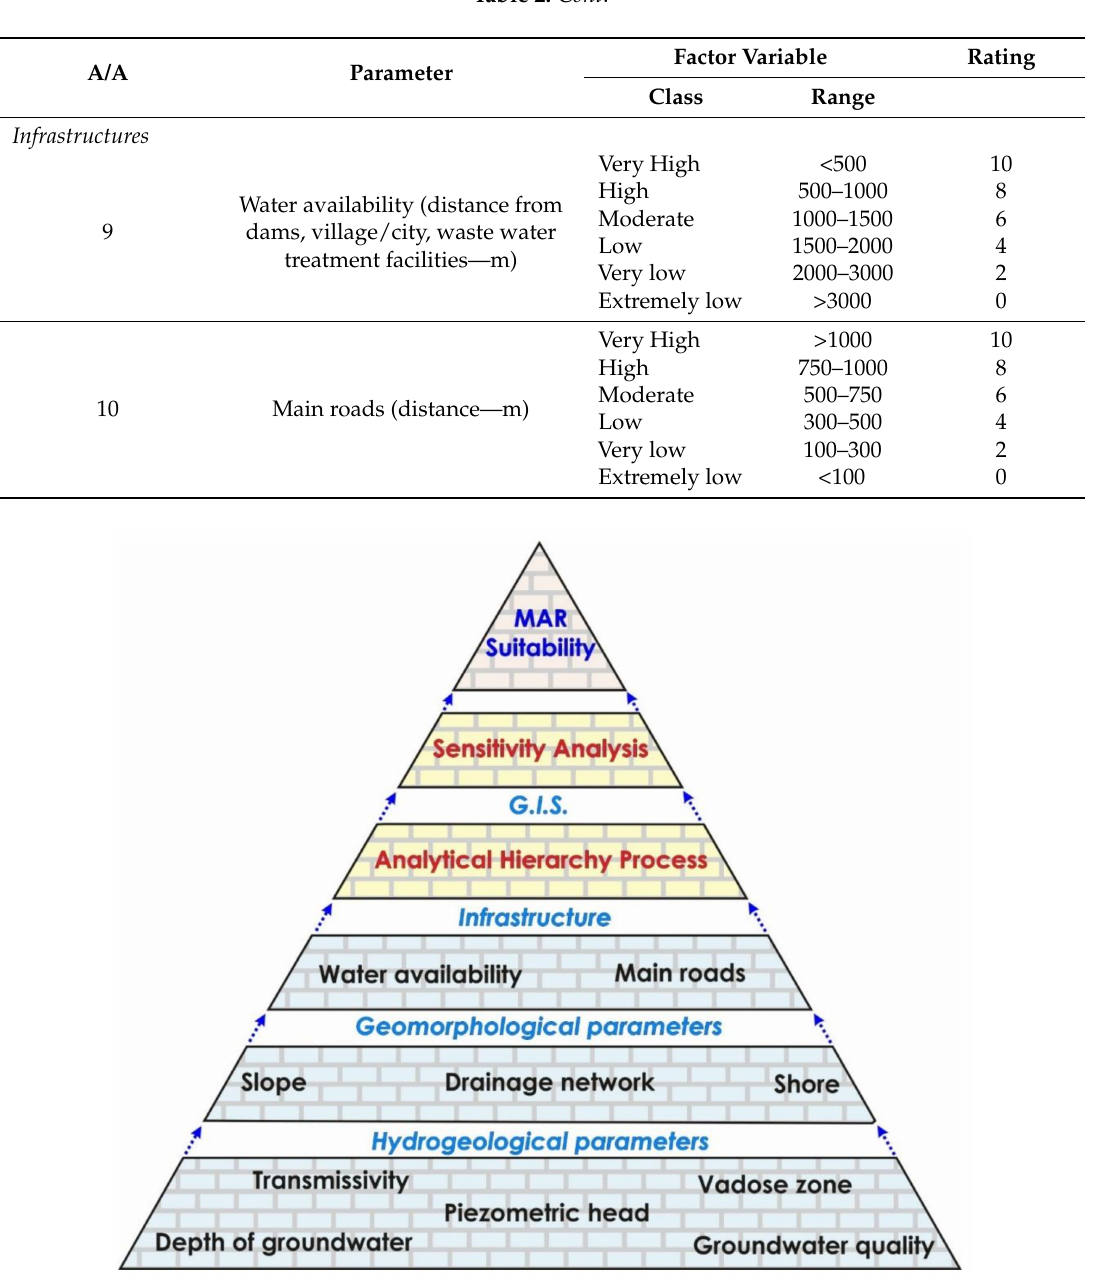
Figure 2. Flow chart of the site suitability index to apply MAR